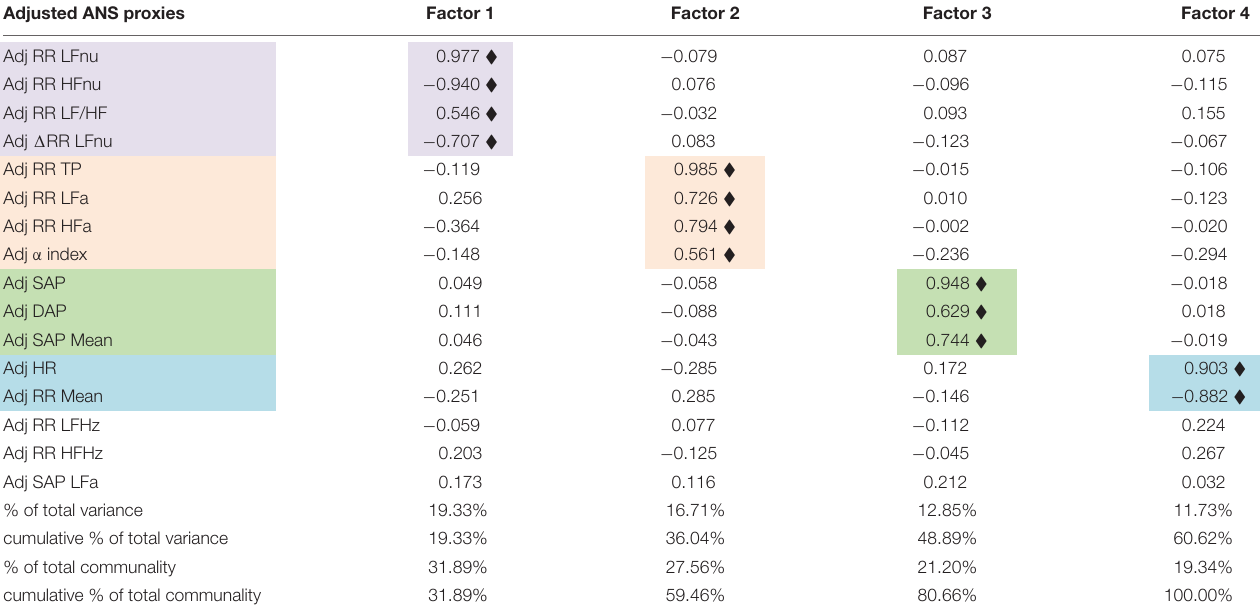
TABLE 4 | Factor analysis with the maximum likelihood extraction method arrested to the first four factors: rotated factor loadings with the varimax method. Adjusted ANS proxies Factor 1 Factor 2 Factor 3